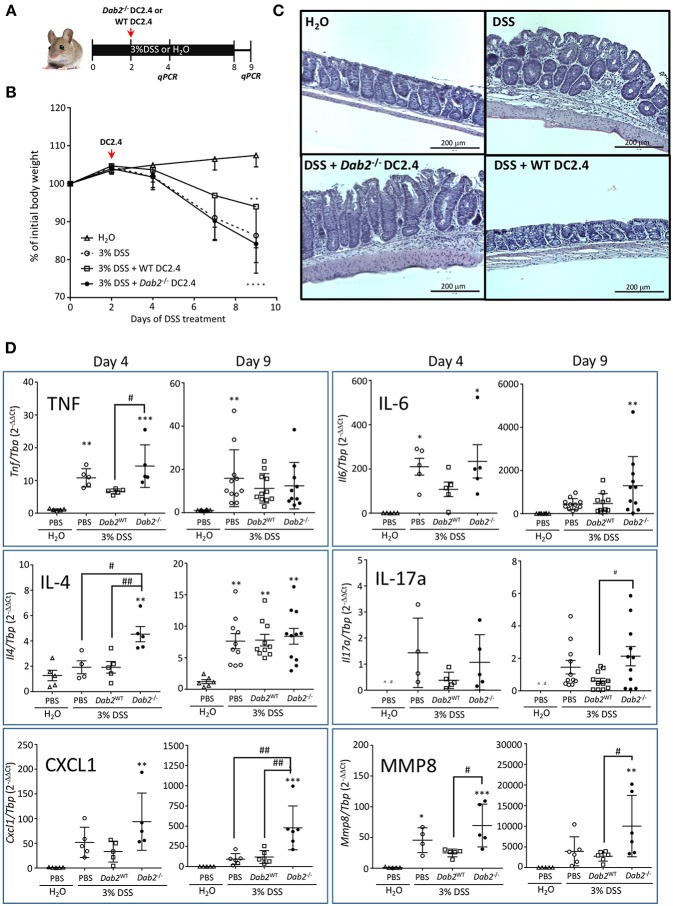
Pro-inflammatory effect of Dab2-deficient DCs during DSS colitis. (A) C57BL/6J mice received 3% DSS in their drinking water or regular water for 8 days. On day 2, mice were intraperitoneally injected with 8.5 × 105 DC 2.4 WT or Dab2−/− cells. Mice were switched to regular water on day 8. Two cohorts of mice were euthanized on days 4 or 9 after DSS treatment. (B) Relative body weight change; n = 8–11 **p < 0.01 and ****p < 0.001 DSS vs. H2O in mice treated with DC2.4WT and DC2.4Dab2−/− cells, respectively. (C) Representative H&E staining of the distal colons from each experimental group (day 9). Bar = 200 μm. (D) Colonic gene expression of selected inflammatory mediators in control and DSS-treated mice by qRT-PCR on days 4 and 9 after DSS treatment. n = 5–11 (*p < 0.05, **p < 0.01 and ***p < 0.005 when compared to untreated mice or #p < 0.05 and ##p < 0.01 in pairs indicated by brackets.